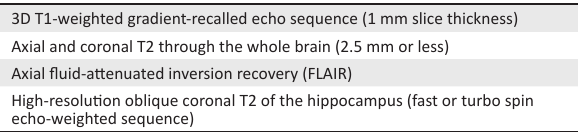
BOX 1: Recommended MRI protocol for epilepsy at 1.5T and